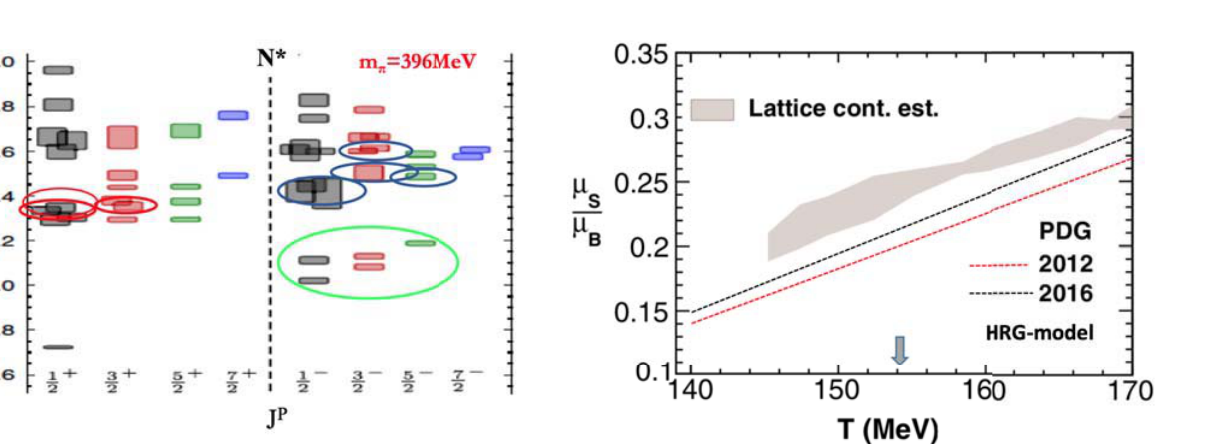
Fig. 7 The ratio of baryon chemical potential of strangeness versus all baryons for the RPP 2014 and RPP 2016. The hashed grey area show the LQCD calculation in ”hot QCD”. The straight lines are calculations within a hadron gas model. The 2016 line, which includes more N/ Δ baryon states, moves closer to the LQCD area. Note that only 3* and 4* states are included. If the newly discovered states in RPP 2018 (seven states that are now at 3* or 4* status) were included this line would be moving even closer to the LQCD